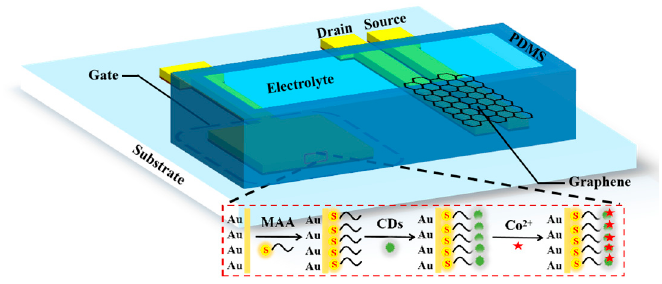
Figure 3 . The scheme of the CD-SGGT sensor for detection of Co 2+